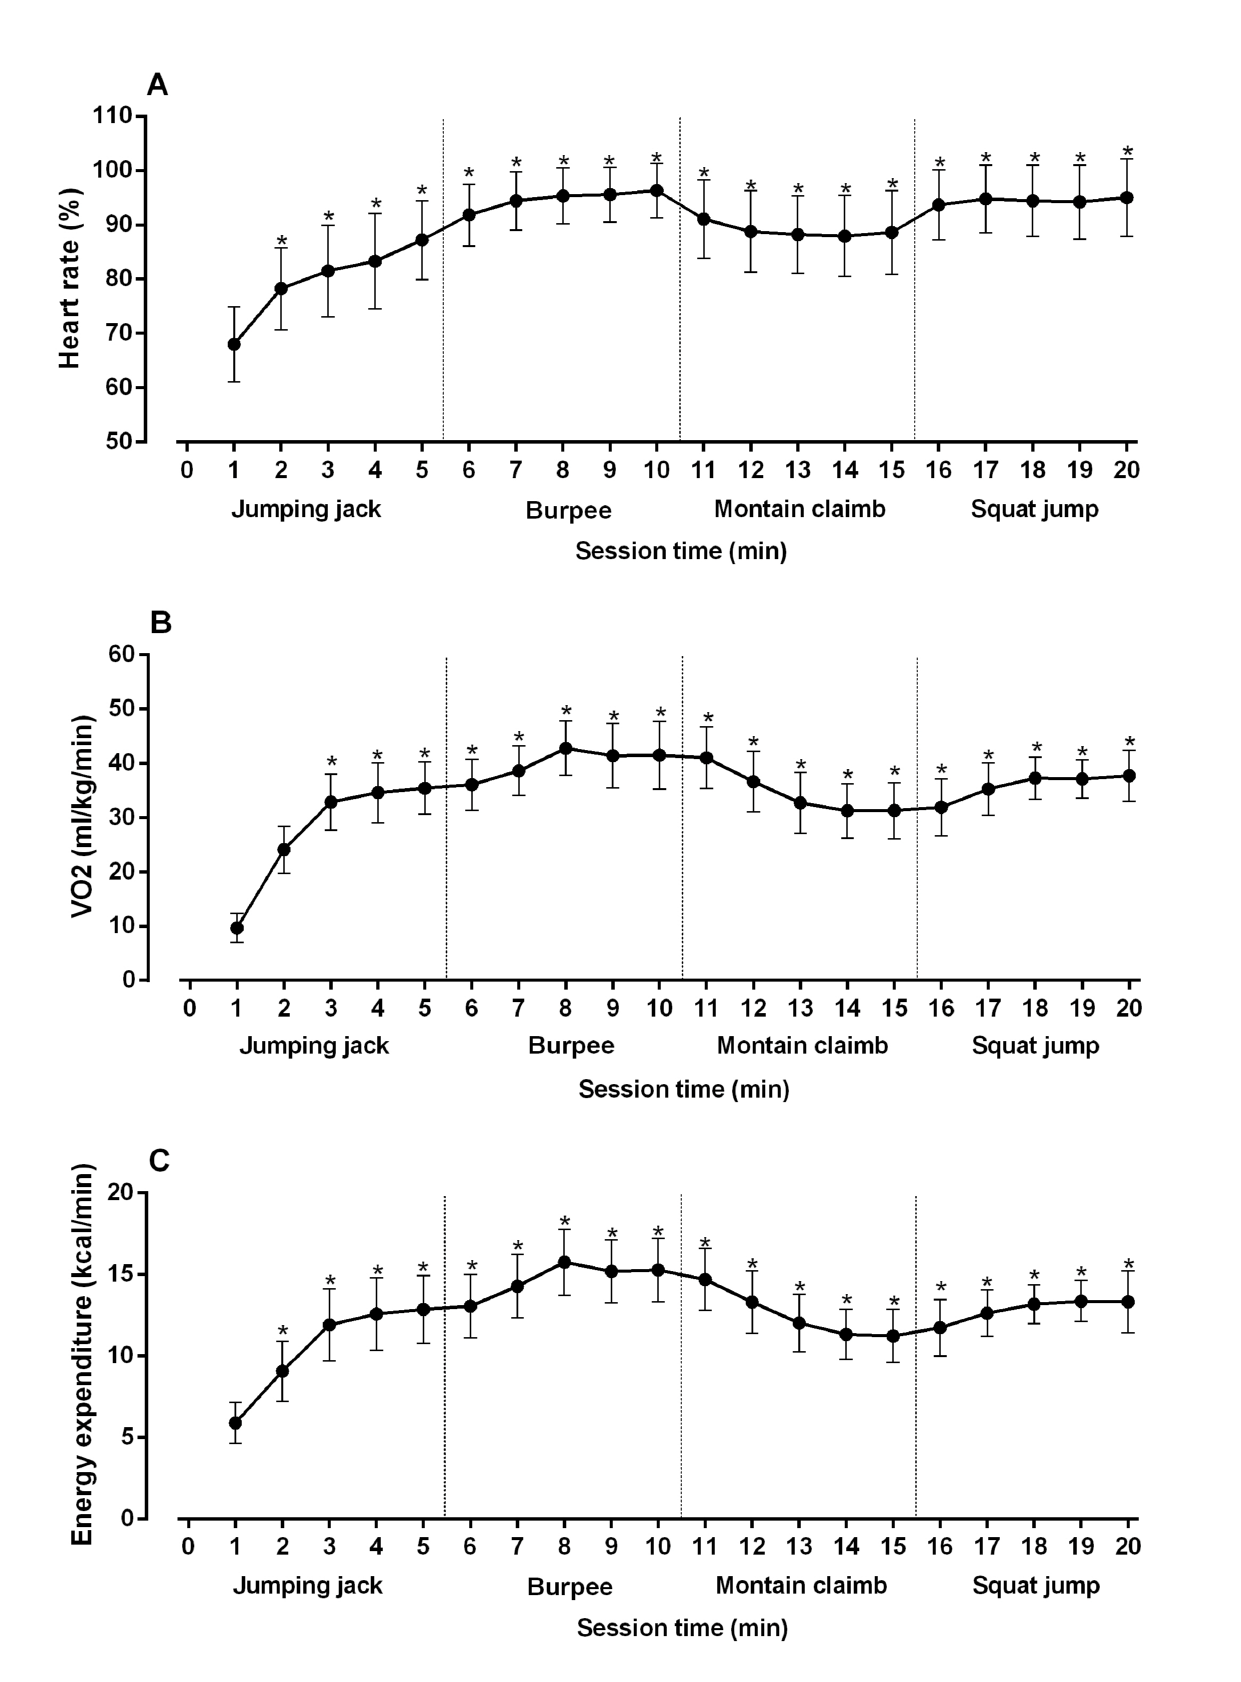
Figure 1 - Values expressed as mean ± standard deviation for % maximal heart rate (Panel A), VO2 (Panel B) and energy expenditure (Panel C). *indicate statistical differences (p< 0.05) from the first